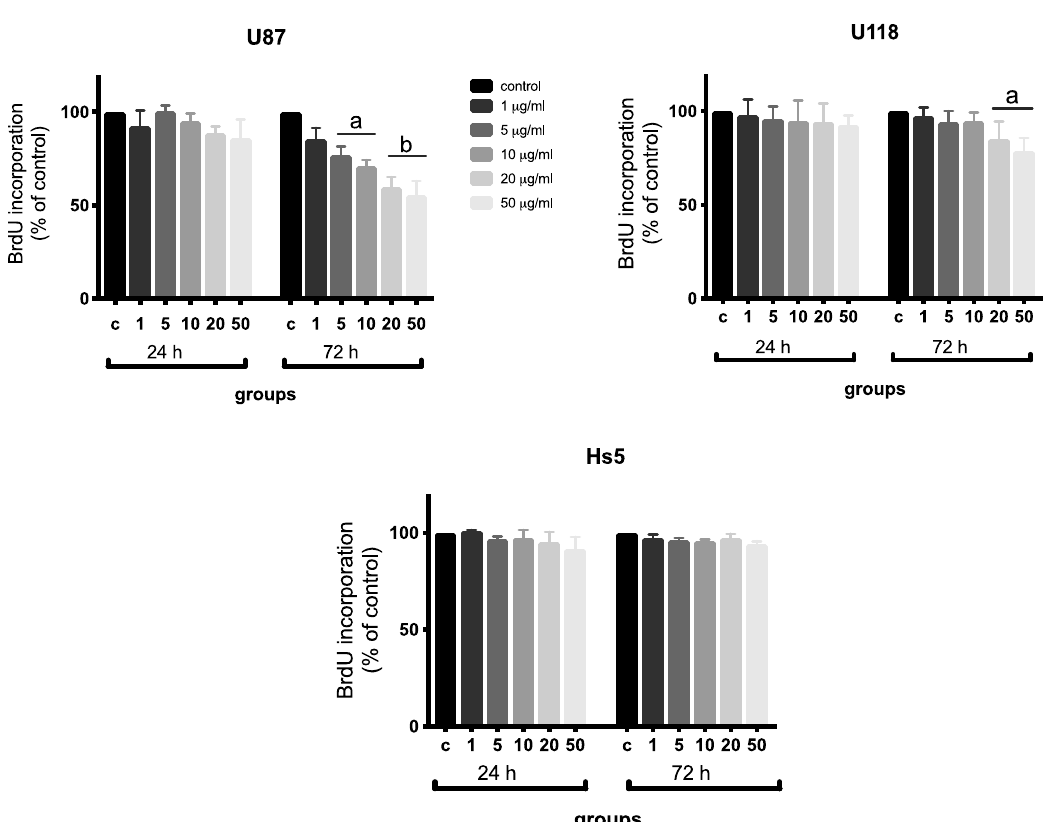
Figure 5. Analysis of proliferation of the Hs5, U87, and U118 cell lines after diamond nanoparticle (ND) treatment at concentrations of 1, 5, 10, 20, and 50 μ g/mL for 24 and 72 h using the Bromodeoxyuridine (BrdU) assay. Values are represented as mean ± standard deviation of the relative percentage of cells to the BrdU positive cells. Groups marked with different letters (a, b) are significantly different ( p < 0.05).